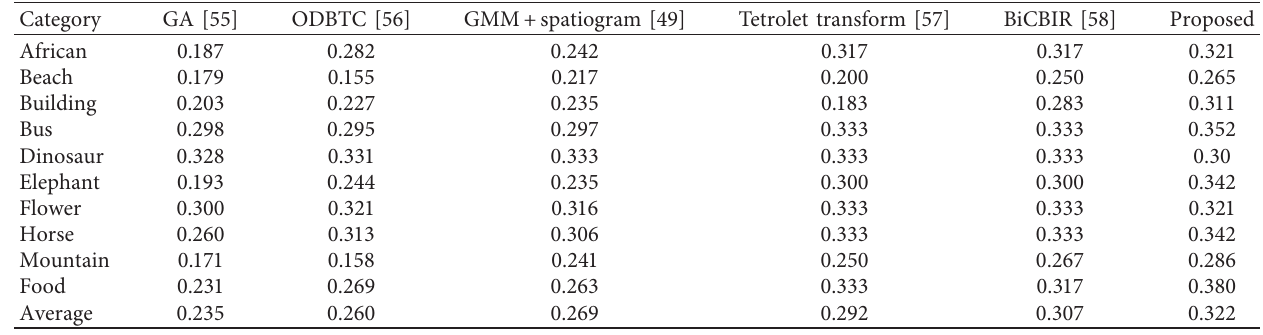
Figure 8: Performance of NRLGO is compared with state-of-the-art descriptors on Corel 10k using precision and recall parameters. Table 13: F-score is compared with state-of-the-art descriptors at Corel 1k.